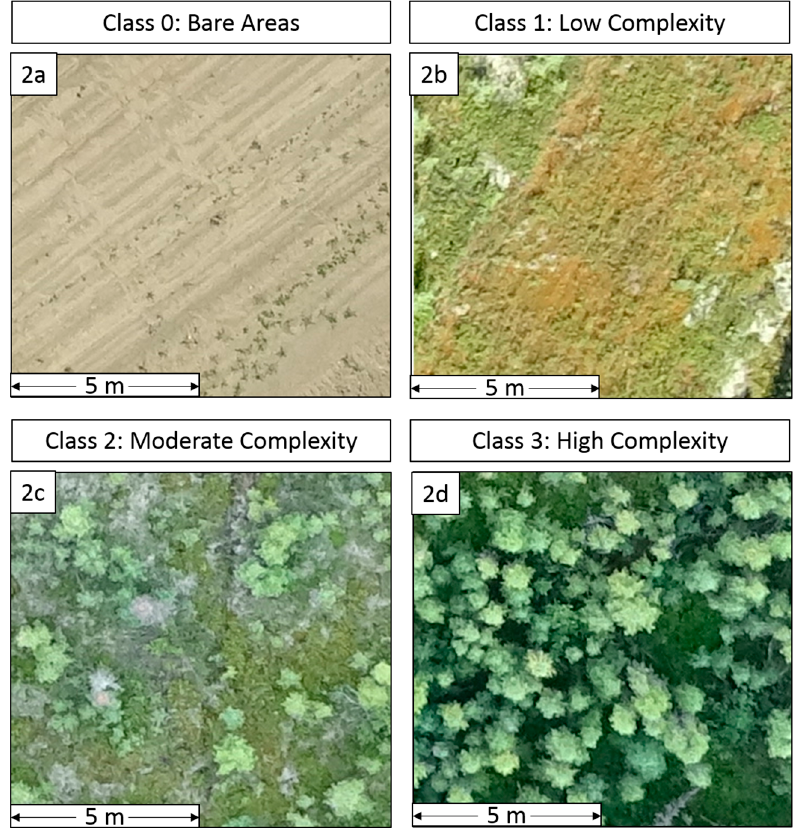
Figure 2. Examples of each surface complexity class found within the study site. Data displayed is captured from the orthophoto. The example of Class 0 ( 2a ) is taken from the new clay road bisecting the study area, Class 1 ( 2b ) is taken from a pipeline ROW, Class 2 ( 2c ) is from undisturbed portions of the bog, and Class 3 ( 2d ) is from densely treed portion of bog.